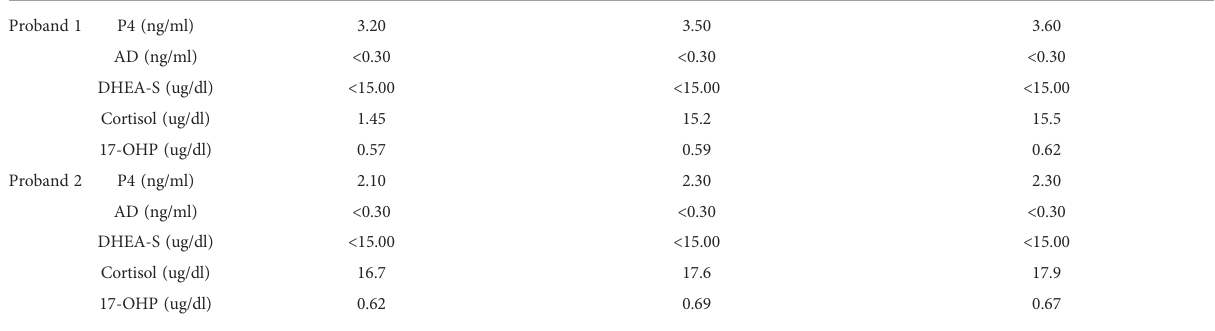
TABLE 3 ACTH stimulating test results of the